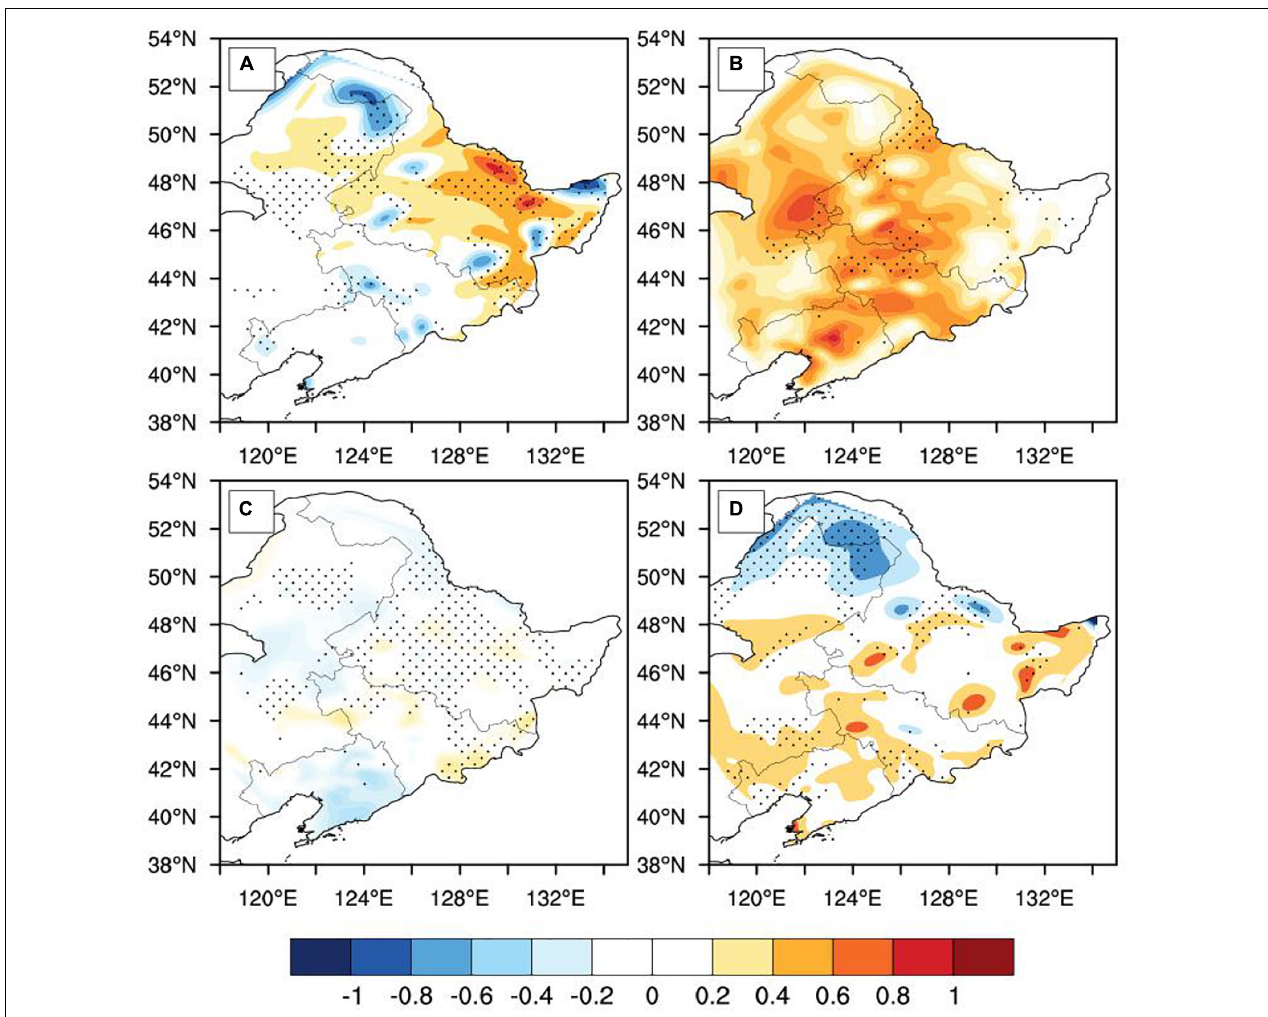
FIGURE 5 | Distribution of the correlation coefficients between the NCCV index and precipitation anomalies in NEC during all the NCCV maintaining days ranging from 1978 to 2018: (A) EM type; (B) SLM type; (C) ESM type; (D) SSM type. In the figure, the dotted areas indicate the areas passed the 95% significance